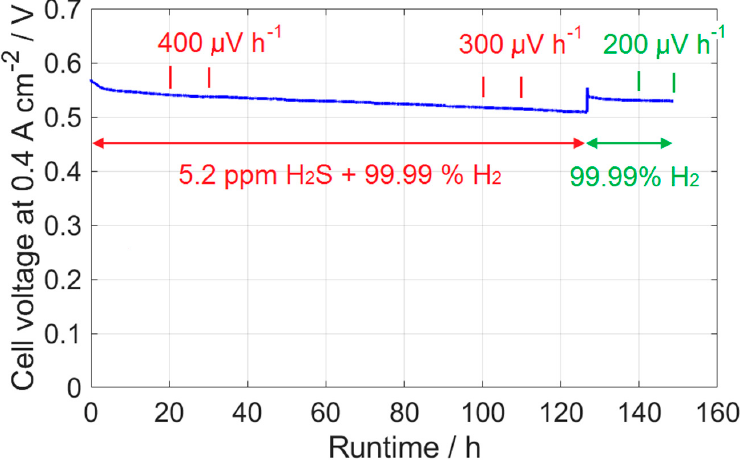
Figure 6. Cell voltage at 0.4 A cm − 2 using 5.2 ppm H 2 S with H 2 balanced and using 99.99% H 2 .